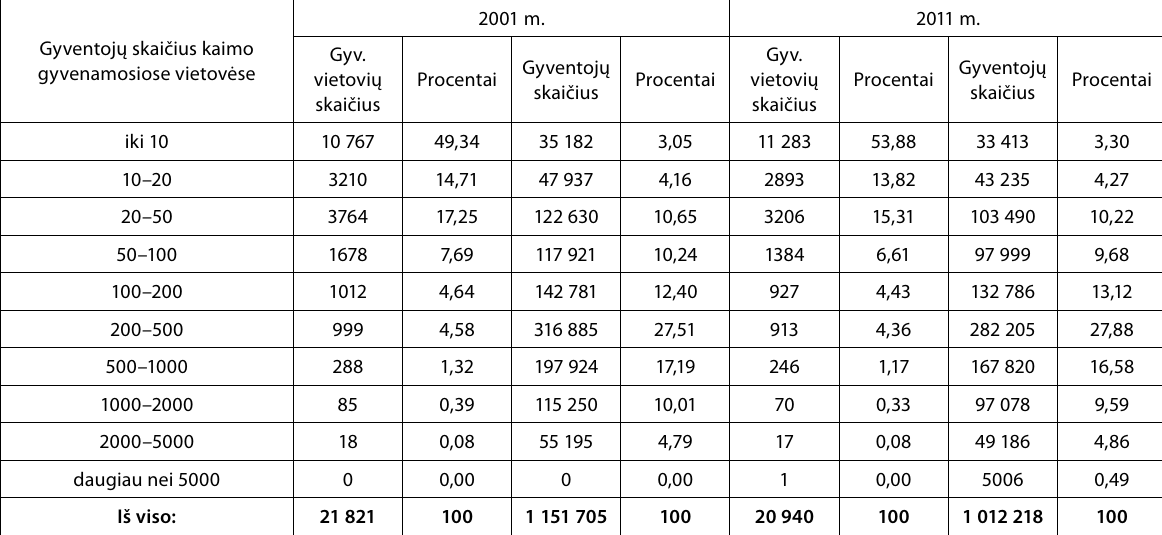
Table 5. The number of rural settlements according population 2001–2011 (according analysis of lithuania statistics department results of Census of population and housing in 2001–2011 of the republic of lithuania) 2001 m. Gyventojų skaičius kaimo gyvenamosiose vietovėse